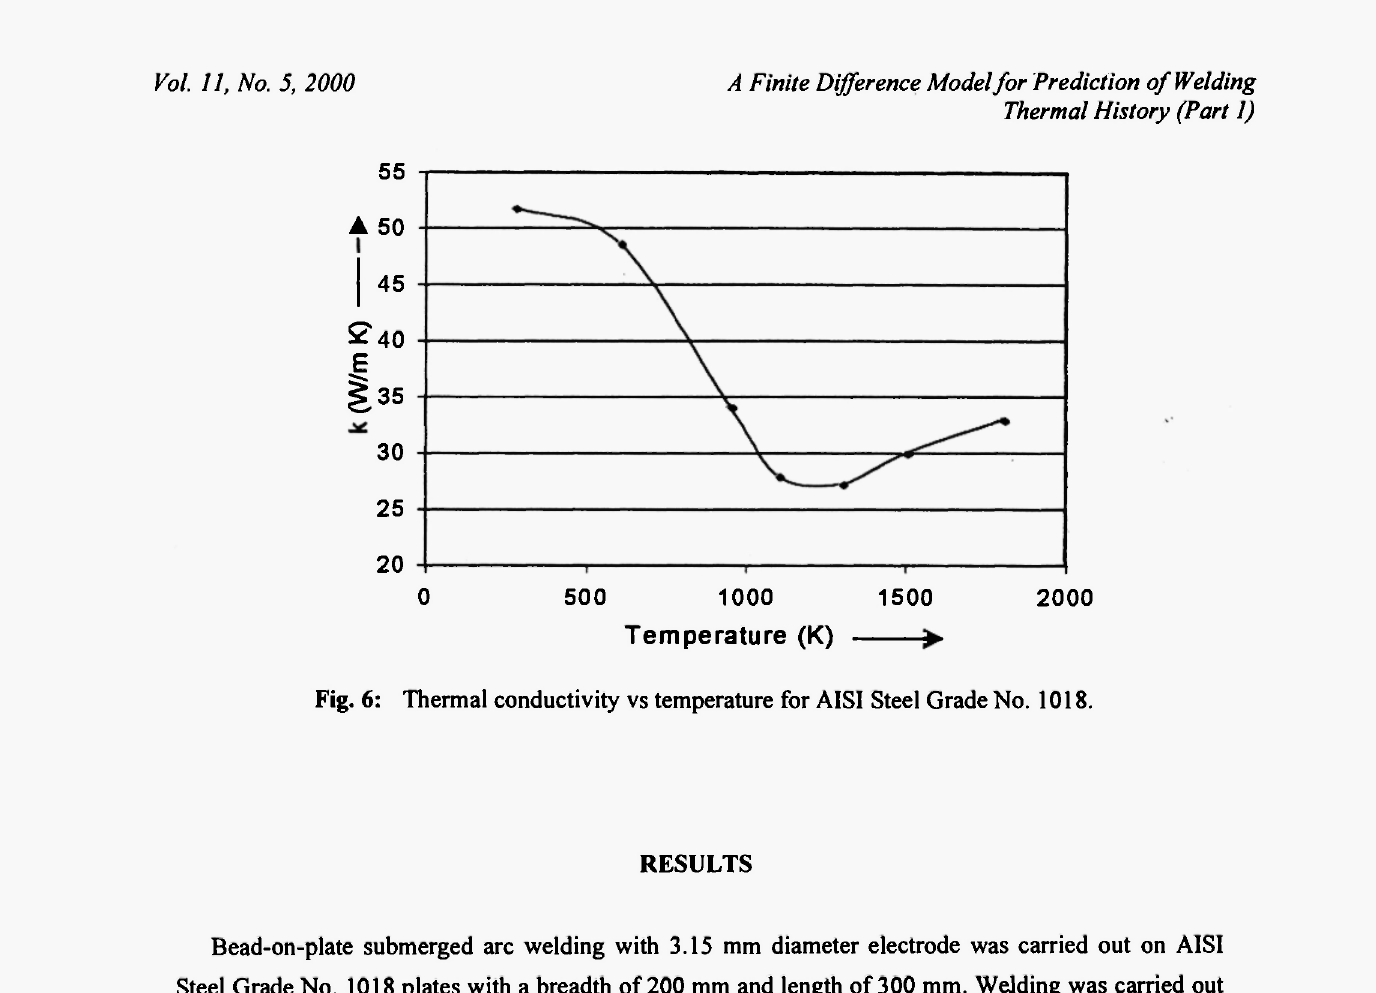
Fig. 6: Thermal conductivity vs temperature for AISI Steel Grade No.